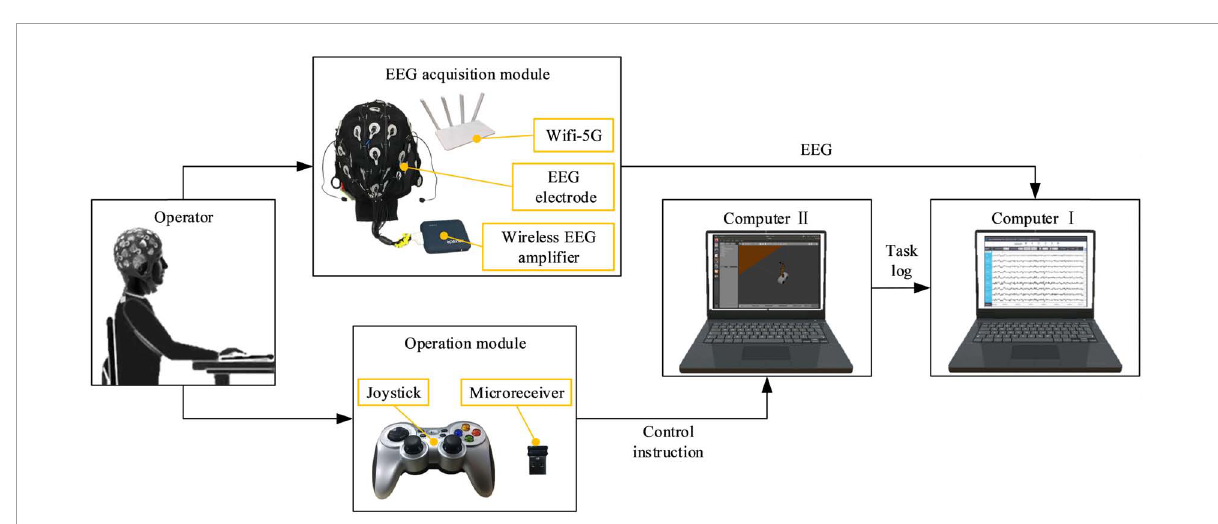
FIGURE2 An overview of the mental state evoked